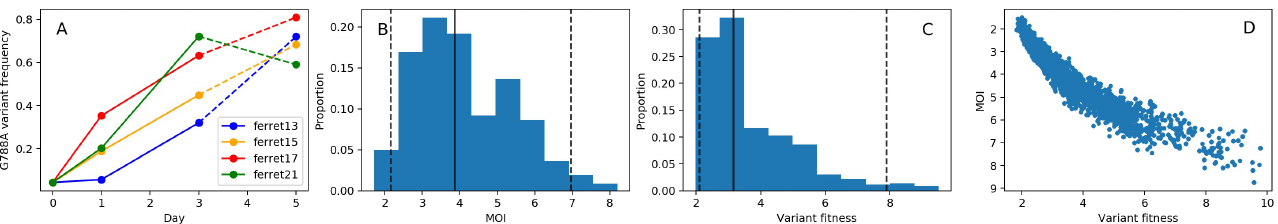
Figure 3. Fitness estimation for variant G788A, assuming deterministic within-host dynamics. ( A ) Measured G788A allele frequencies over the course of infection for 4 experimentally infected ferrets. Days 0 (stock frequency), 1, and 3 are used in the estimation of variant fitness. ( B ) Posterior distribution for the mean cellular multiplicity of infection. ( C ) Posterior distribution for variant fitness. In ( B , C ), black solid lines show the median values of the posterior densities and black dashed lines show the 95% credible intervals. ( D ) Joint density plot for MOI and variant